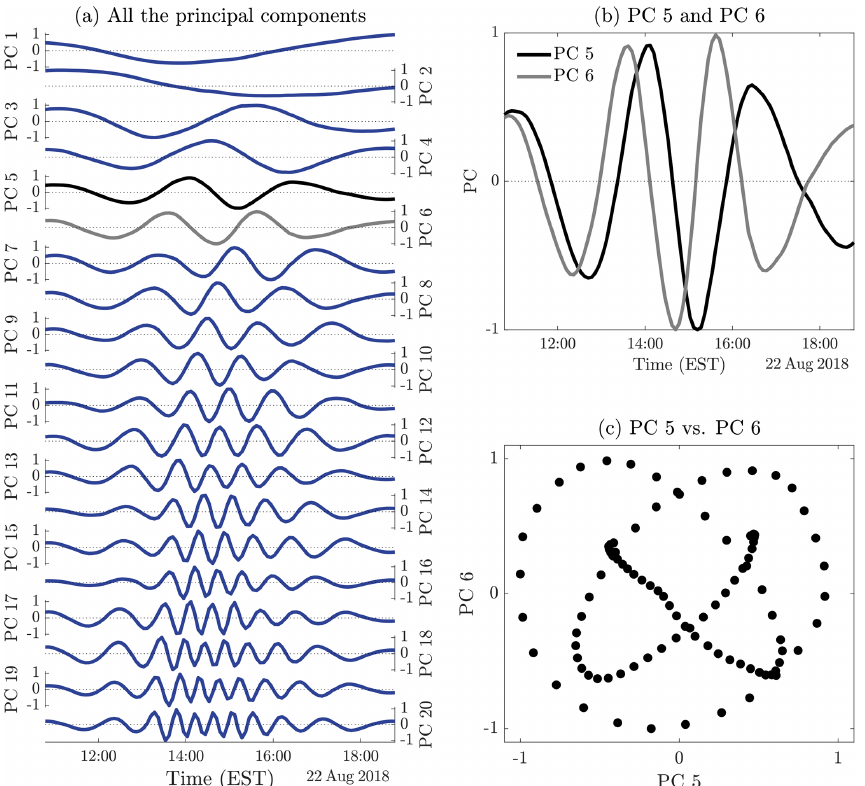
Figure 5. Time series of the 20 PCs; PC5 and PC6 are marked in black and gray, respectively (a) . Time series of PC5 and PC6 (b) and phase diagram of PC5 versus PC6 (c)